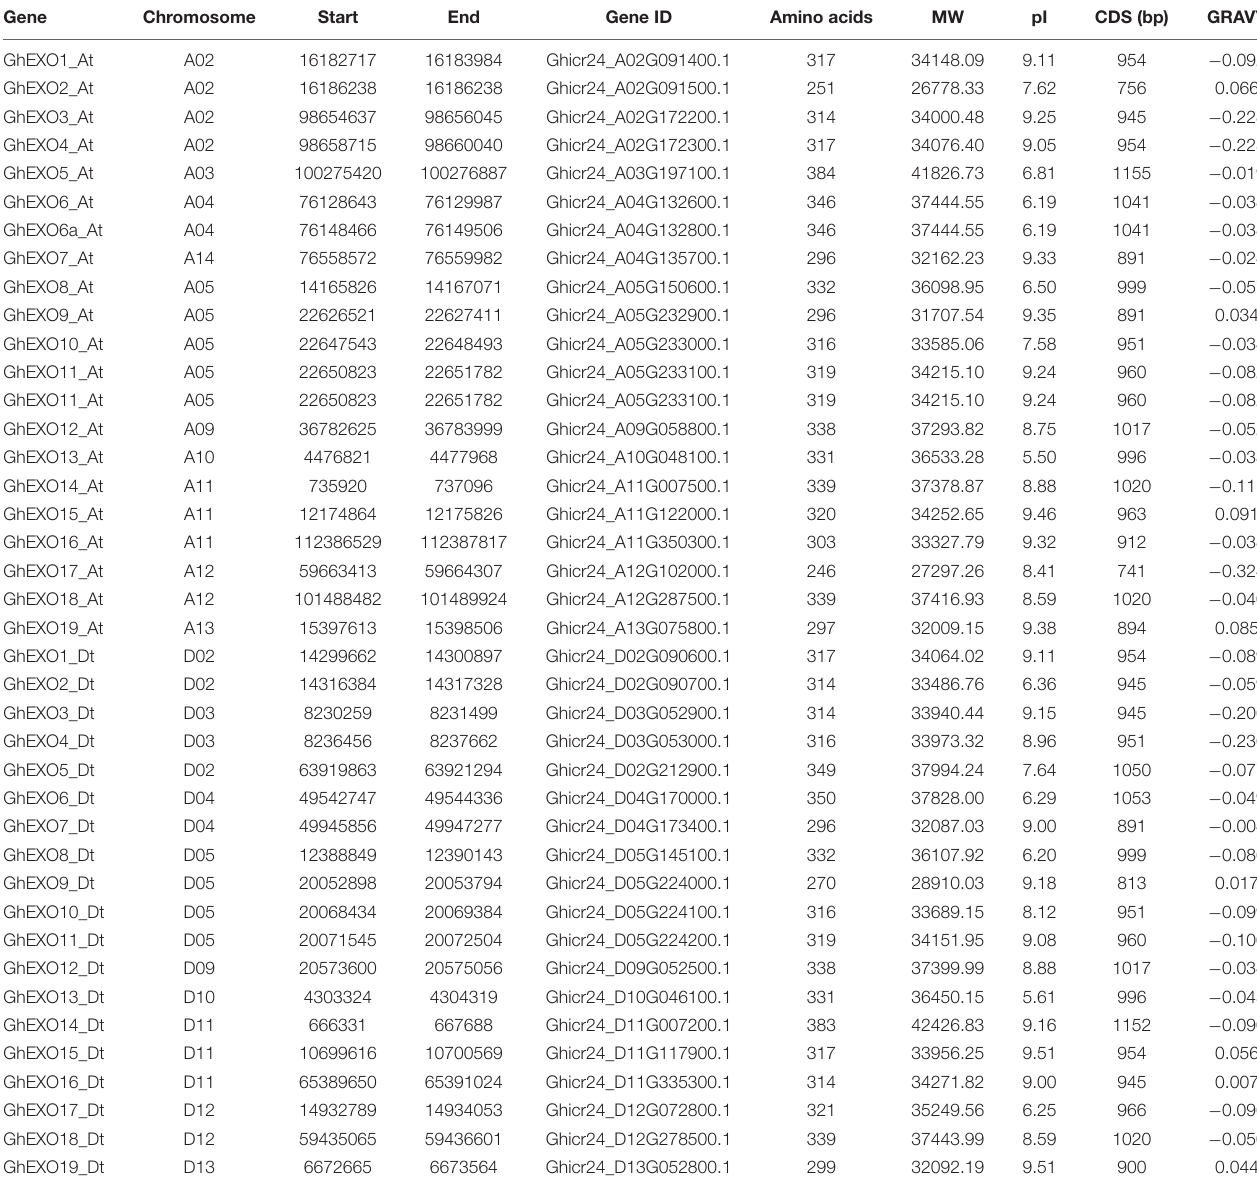
TABLE 1 | Biophysical properties of the predicted GhEXO